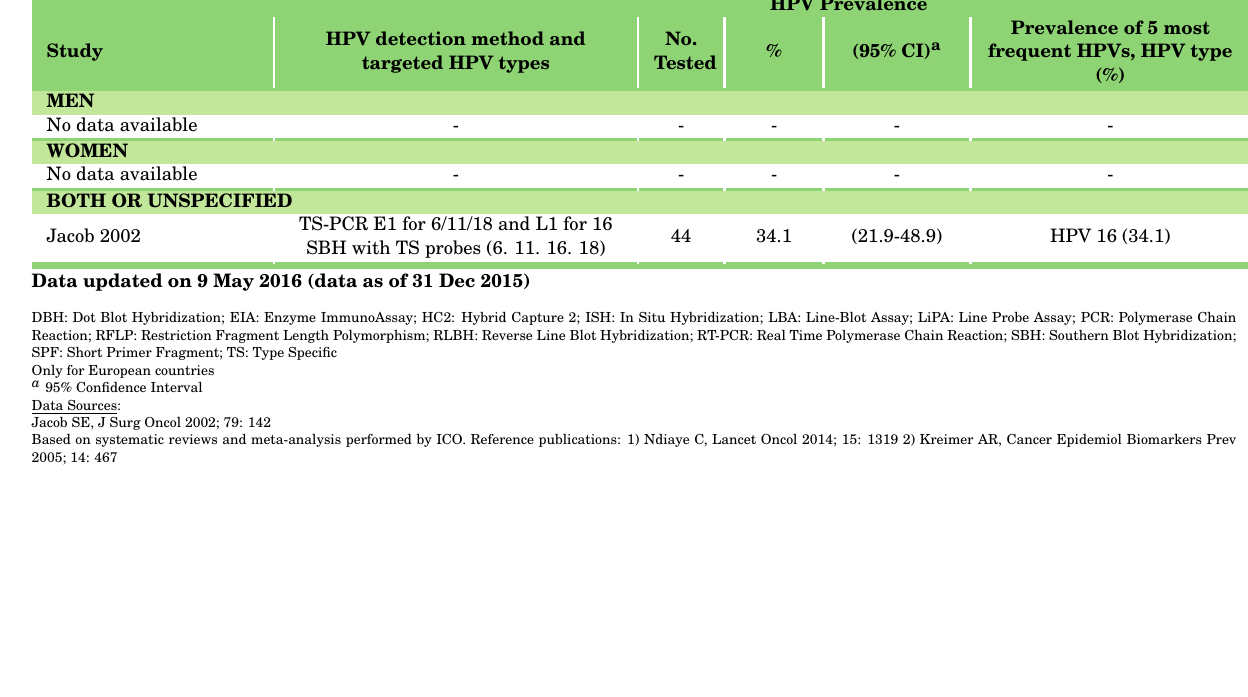
Table 38: Studies on HPV prevalence among cases of hypopharyngeal or laryngeal cancer in